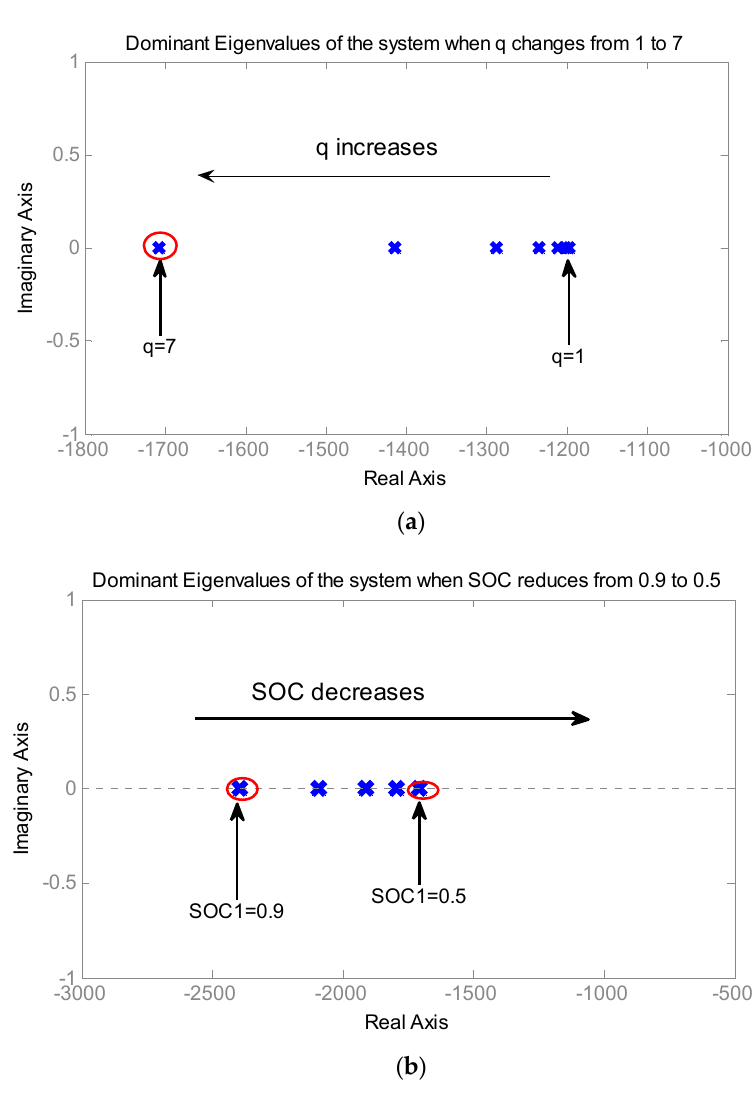
Figure 7. Dominant eigenvalues of the system. ( a ) Root locus with change of q and ( b ) root locus with change of SOC.